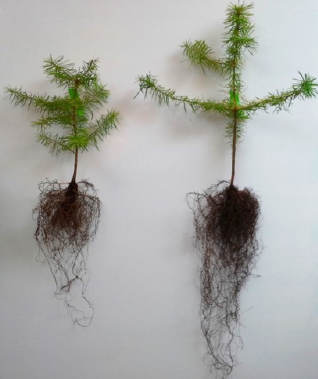
Figure 1. Representative photograph of mock-inoculated (left) and inoculated (right) Douglas-fir seedling after 15 months of growth in nutrient-poor soil.